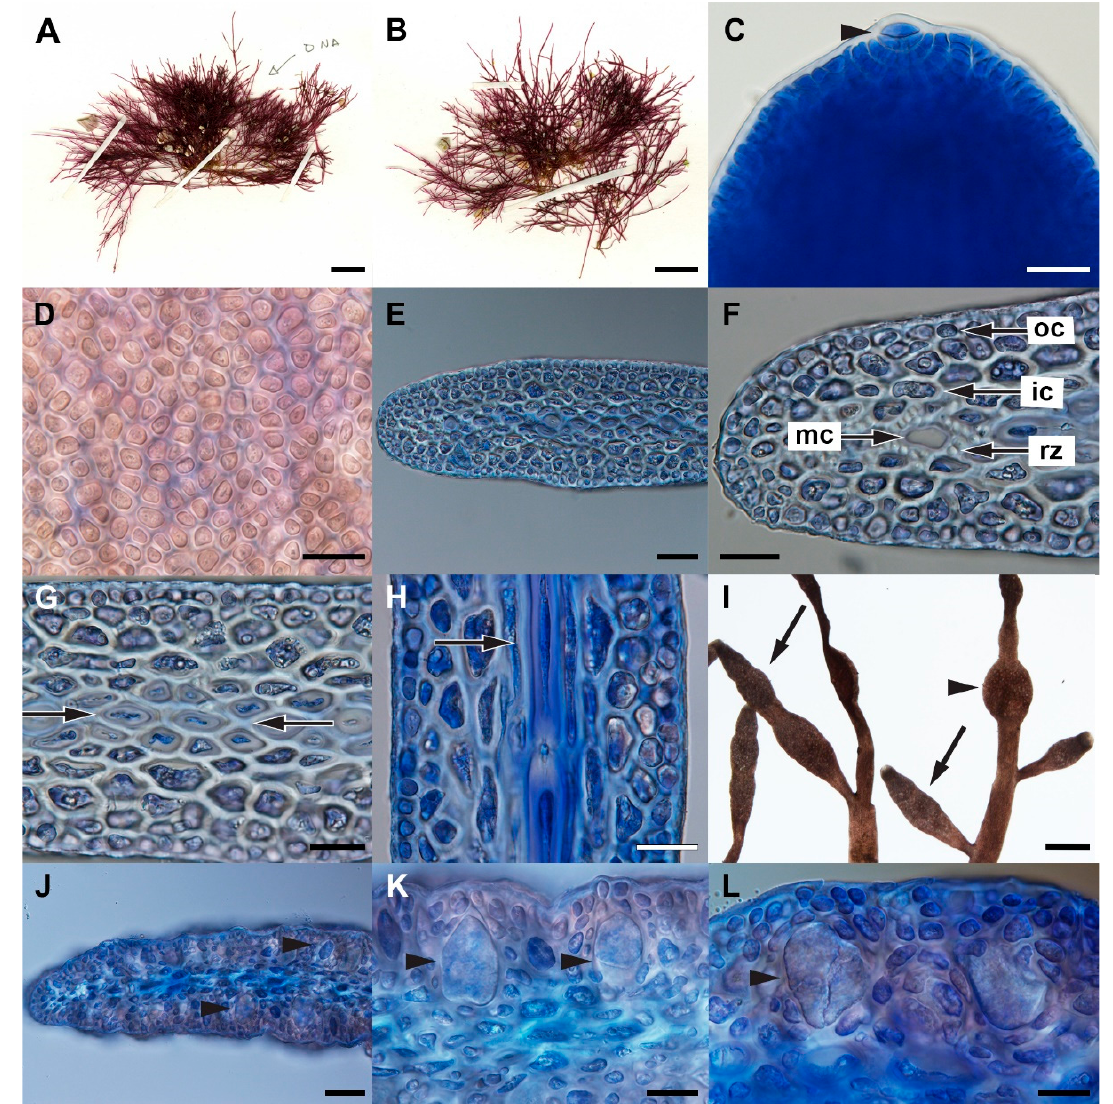
Figure 4. Gelidium leptum sp. nov. from southern Madagascar. ( A ) Holotype specimen; ( B ) isotype specimen; ( C ) obtuse apex of an erect axis with a prominent apical cell (arrowhead); ( D ) irregularly arranged outermost cortical cell; ( E ) transverse section through an erect axis showing cortex and medulla; ( F ) enlargement of Figure 4E showing outermost cortical cells (oc), inner cortical cells (ic), internal rhizoidal filaments (rz), and medullary cells (mc); ( G ) transverse section through a middle part of erect axis showing thick-walled medulla cells (arrows); ( H ) longitudinal section of erect axis showing thick-walled medullary cells (arrow, note the lack of internal rhizoidal filaments); ( I ) elongate tetrasporangial sori (arrows) at the upper branches and round parasporangial cluster (arrowheads); ( J ) transverse section through the tetrasporangial sorus showing tetrasporangia (arrowhead) arising from inner cortex; ( K ) transverse section through the tetrasporangial sorus, showing early development of tetrasporangia (arrowheads); ( L ) transverse section through the tetrasporangial sorus showing decussately divided tetrasporangia (arrowhead). Scale bars: 1 cm ( A , B ), 400 μ m ( I ), 40 μ m ( E , J ), and 20 μ m ( C , D , F – H , K , L ).